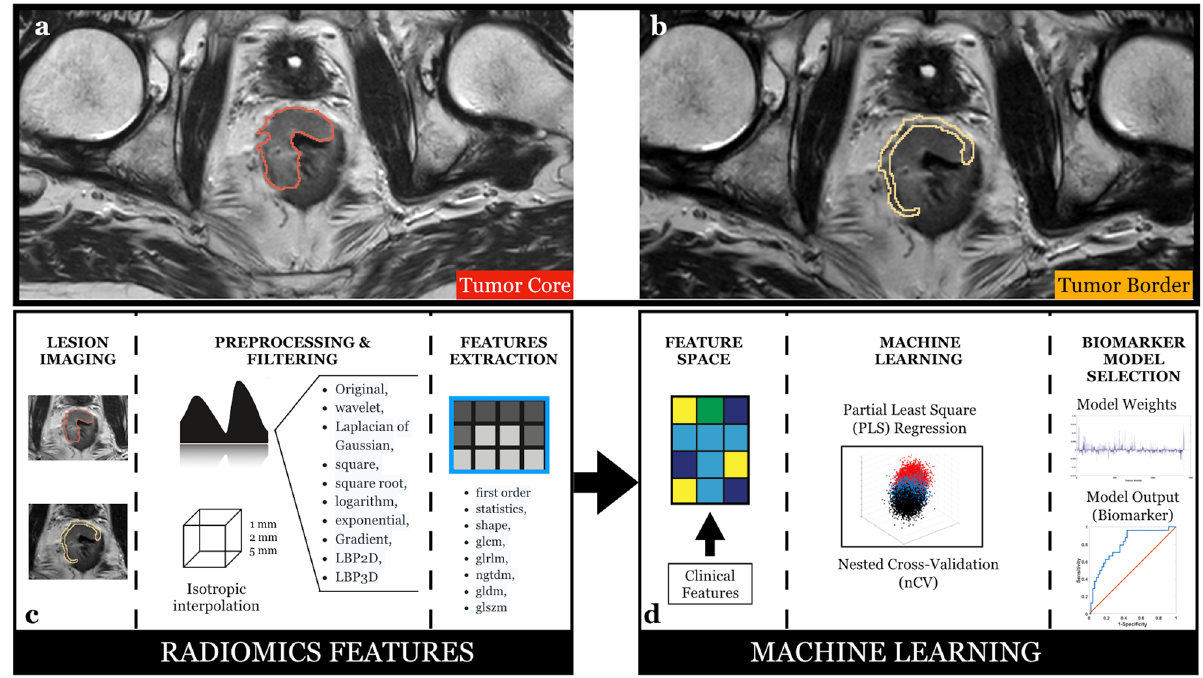
Figure 3. ( a ) Tumor core and ( b ) tumor border on baseline T2-weighted images. ( c ) Schematic representation of the radiomic features extraction process and ( d ) the machine learning